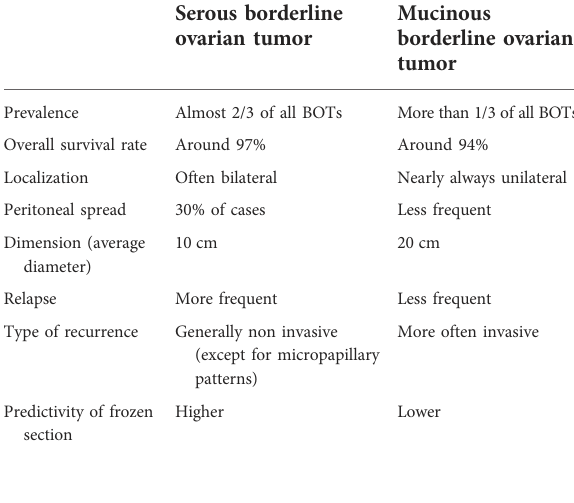
TABLE 1 Main characteristics of the two most common BOTs histotypes.